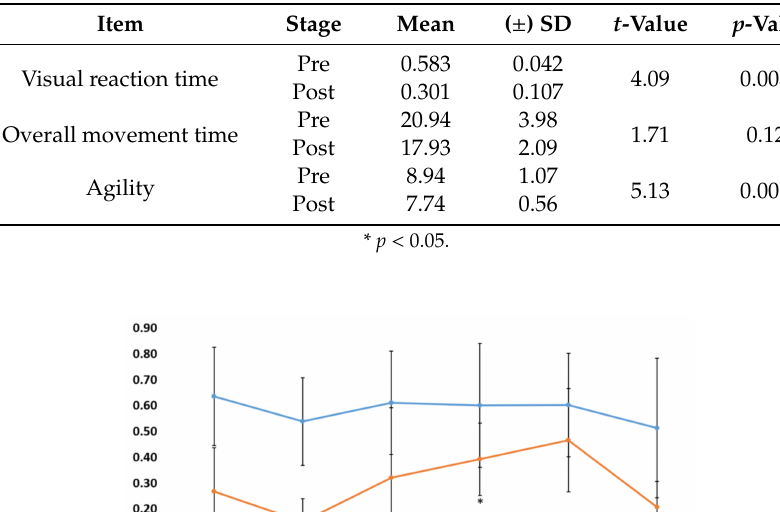
Table 3. A comparison of the various pre-training and post-training indicators.